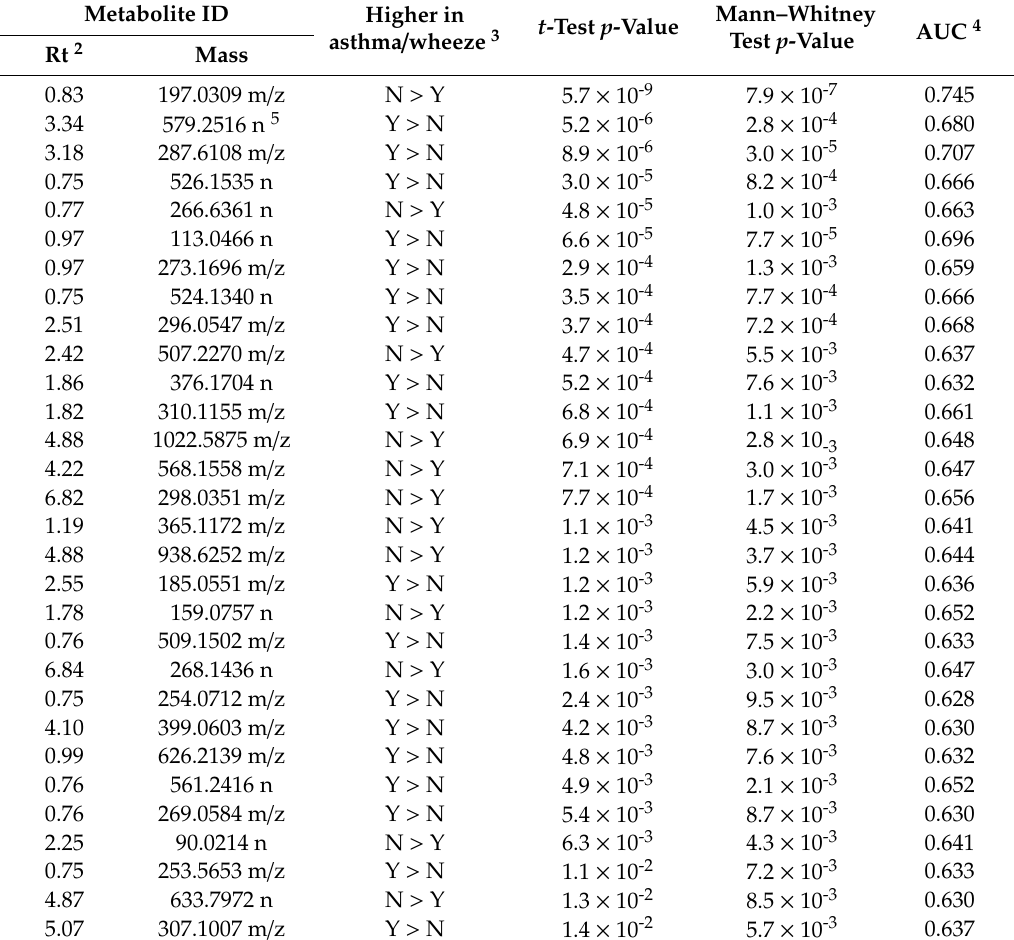
Table 2. Univariate data analysis results for COPSAC2010 1